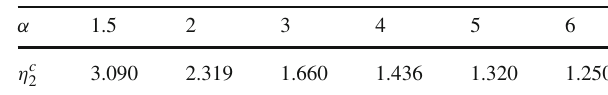
Table 1 η c with different α for T = 0 . 01 2